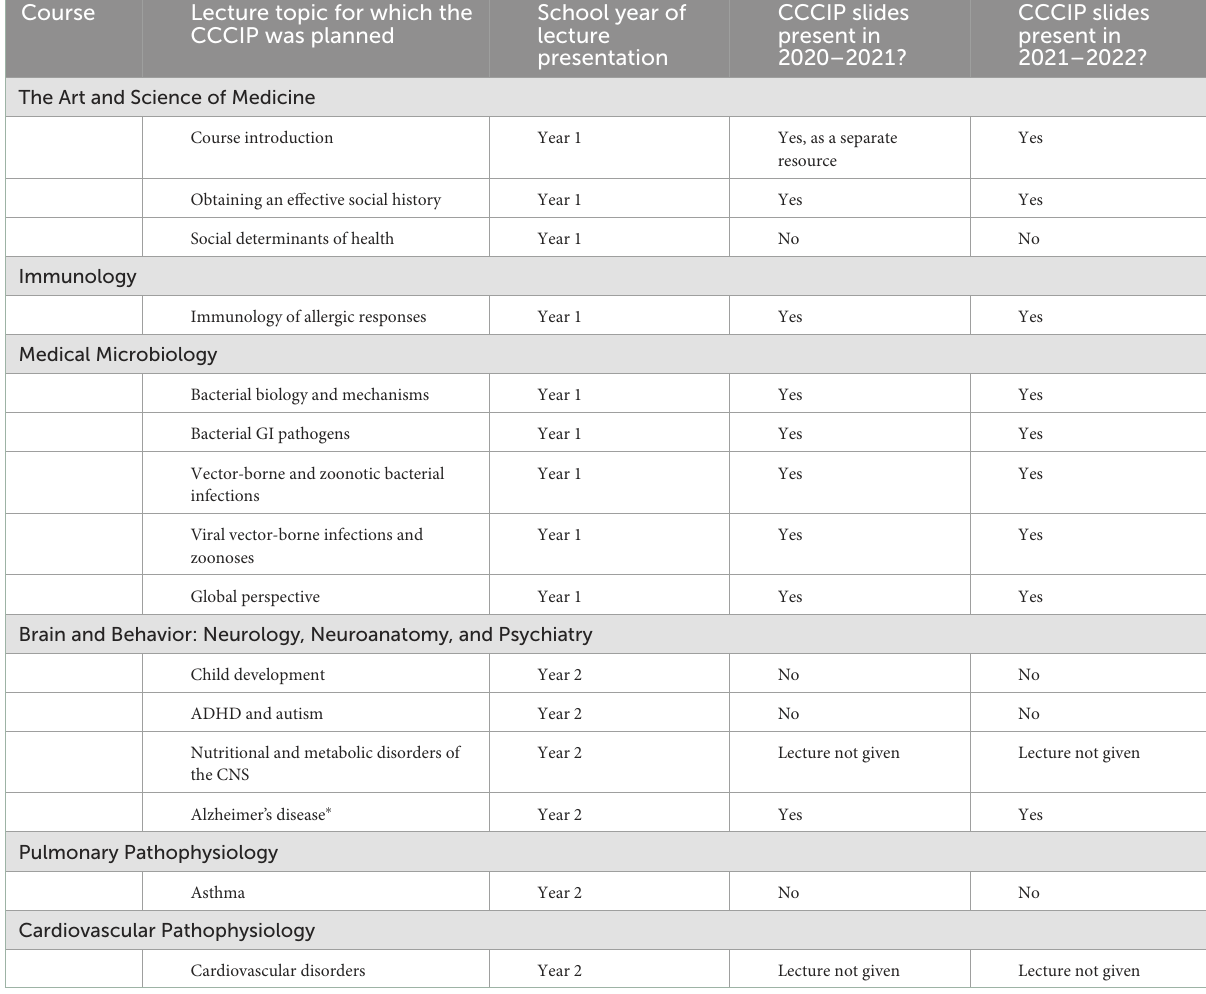
TABLE 2 Results of the retrospective (2020–2022) review of CCCIP inclusion, presented in chronological order of content delivery through the 2 years of the pre-clerkship